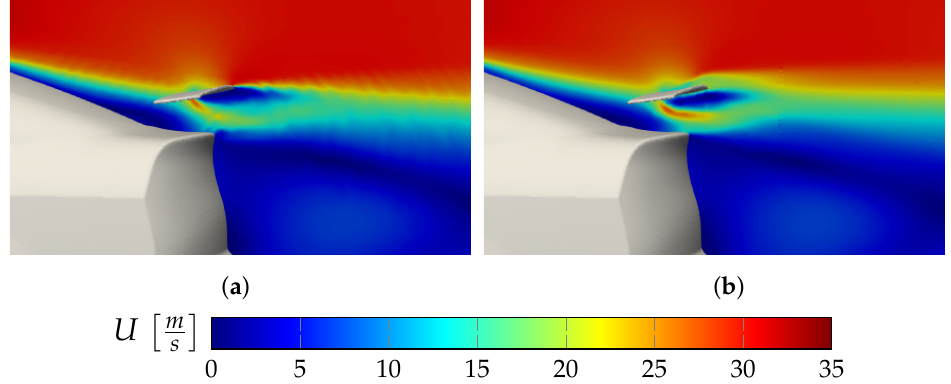
Figure 16. Comparison of oPOD prediction with alternative POD+I prediction. ( a ) oPOD prediction close up. ( b ) Alternative POD+I close